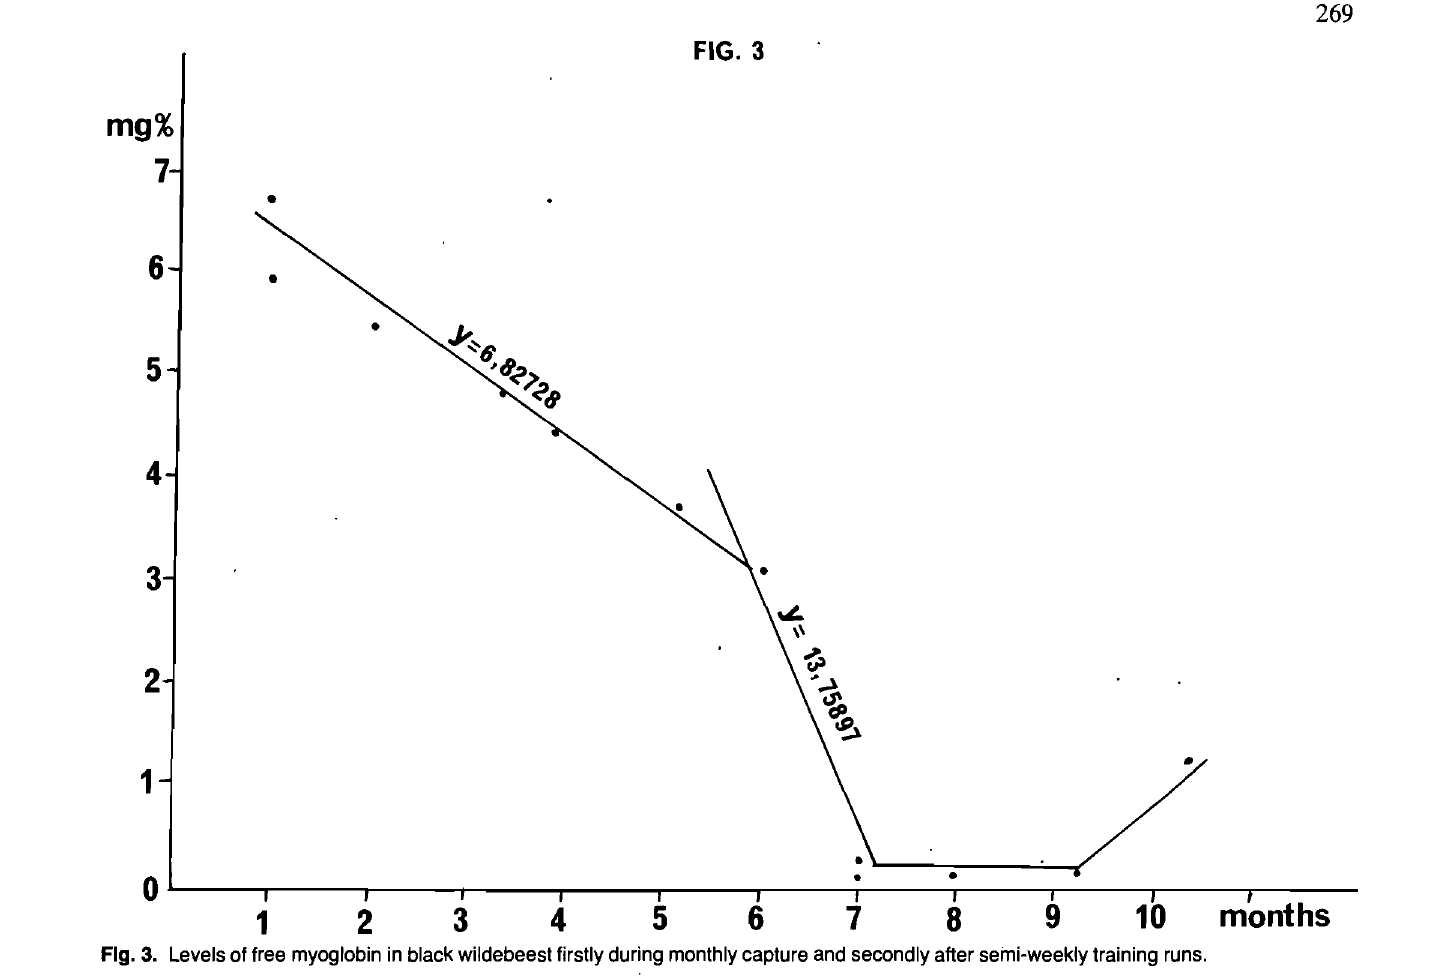
Fig. 3. Levels of free myoglobin in black wildebeest firslly during monthly capture and secondly after seini-weekly training